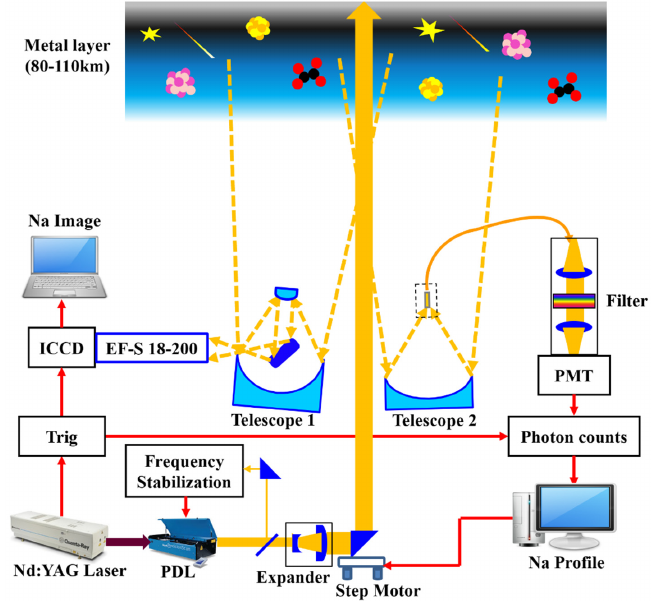
Figure 1. The system layout of the Multilayer Na imager: the Na imager (left of the orange lidar beam) alongside of a high power Na lidar (right of the orange lidar beam). Table 1. Main technical specifications of the Na imager and the Na lidar.